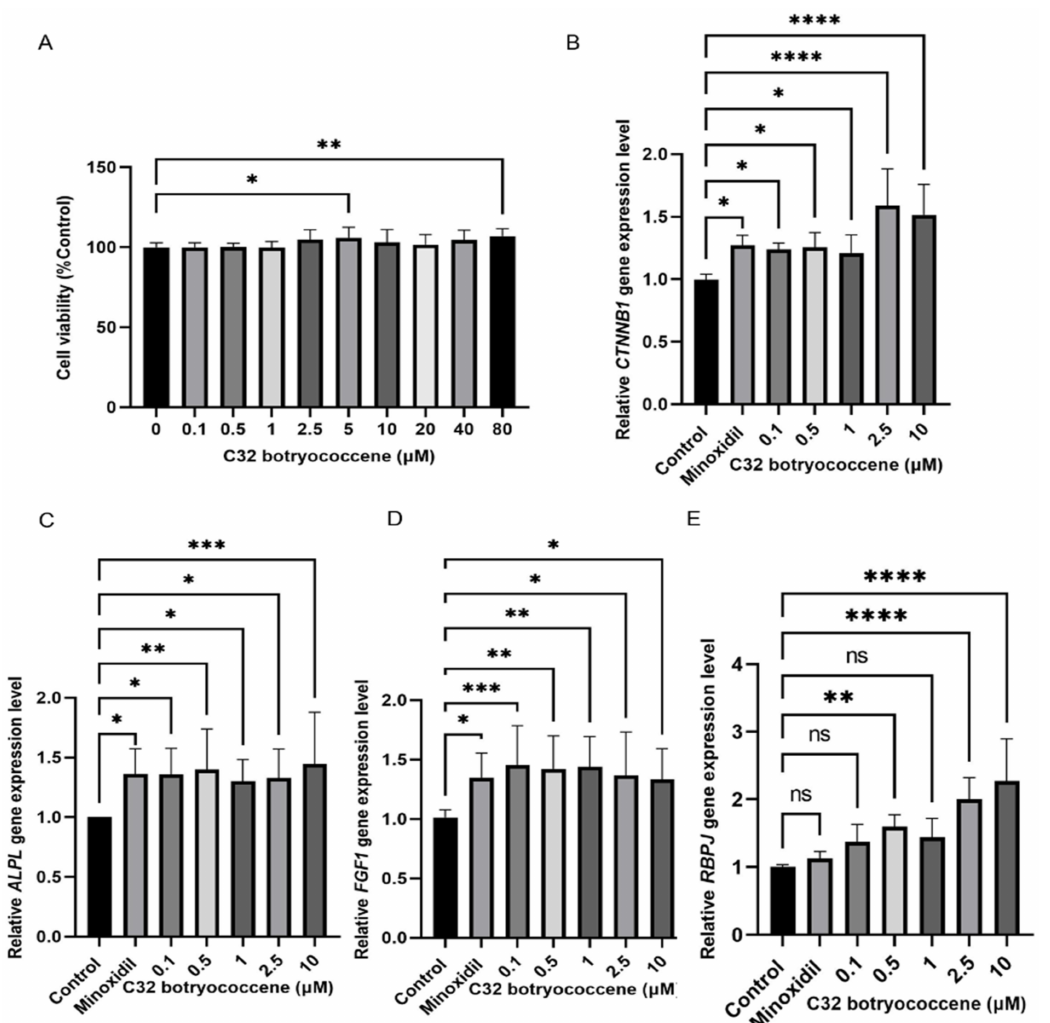
Figure 8. C32 botryococcene enhanced the gene expression of hair growth-associated markers. ( A ) Determination of the relative cell viability of HFDPCs after C32 botryococcene treatment for 48 h. Validation of the relative gene expression of ( B ) CTNNB1, ( C ) ALPL , ( D ) FGF1, and ( E ) RBPJ . The results are expresses using the mean ± SD of three replicates. An ANOVA test was used to assess the level of significance between the groups. * Statistically significant ( p -value ≤ 0.05), ** statistically significant ( p -value ≤ 0.01), *** statistically significant ( p -value ≤ 0.001), **** statistically significant ( p -value ≤ 0.0001), ns (not